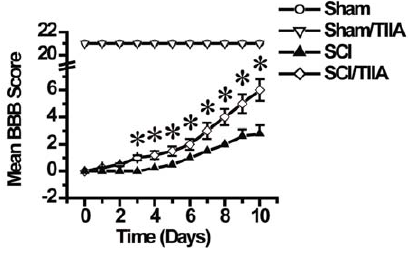
Figure 1. Effects of TIIA on functional recovery after SCI. The function of hindlimb recovery was accessed from day 1 to day 10 after SCI by Basso, Beattie and Bresnahan scores. The hindlimb dysfunction was ameliorated with treatment of TIIA (20 mg/kg). Bars represent means 6 SEM. * p , 0.05 vs. SCI group.